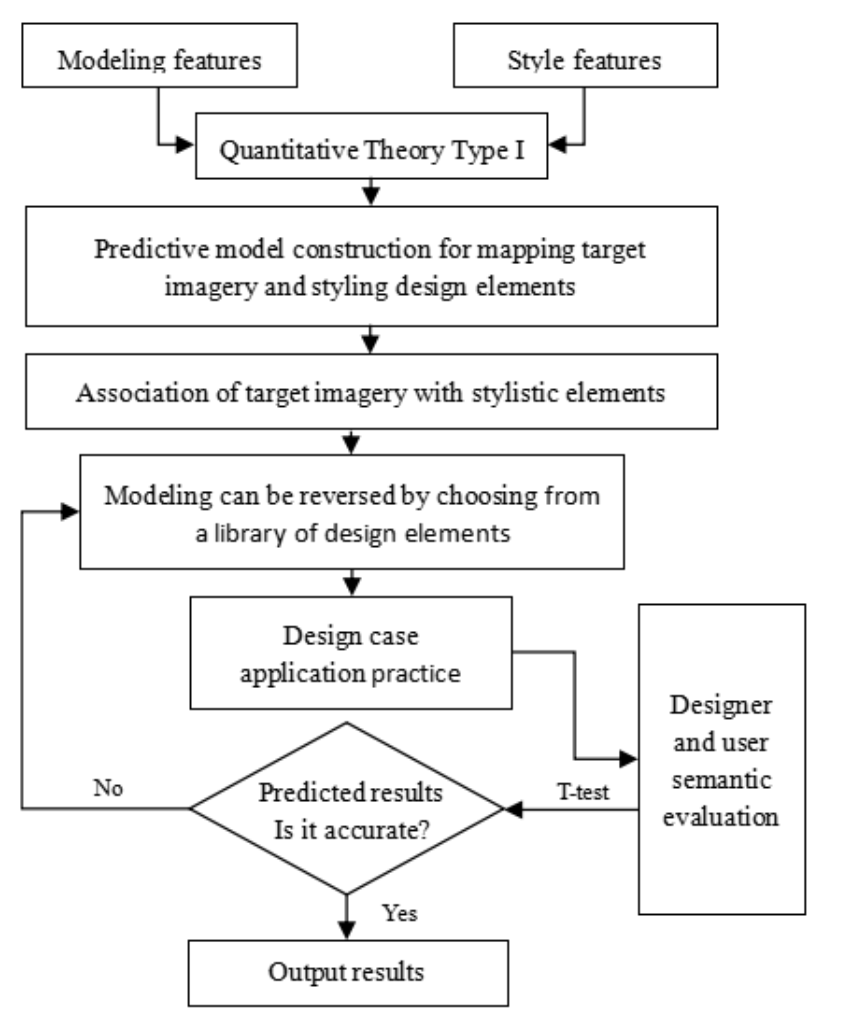
Figure 3. Mapping prediction model construction flow chart.